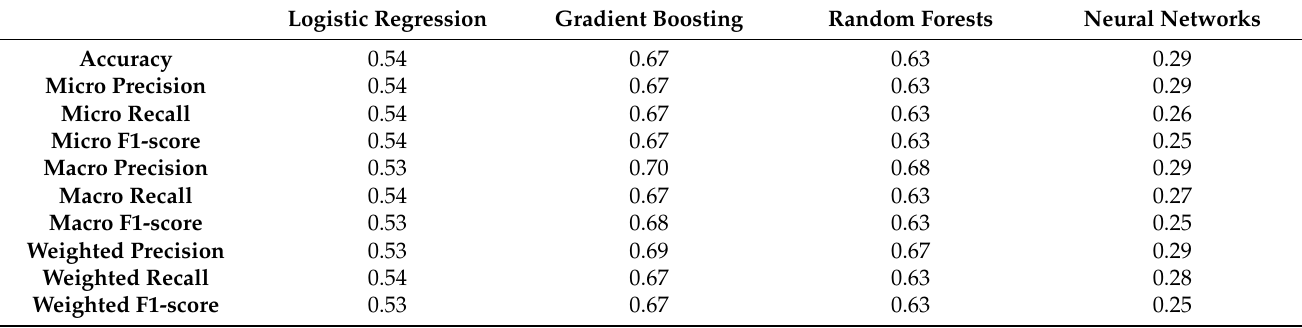
Table 8. Traffic status—results